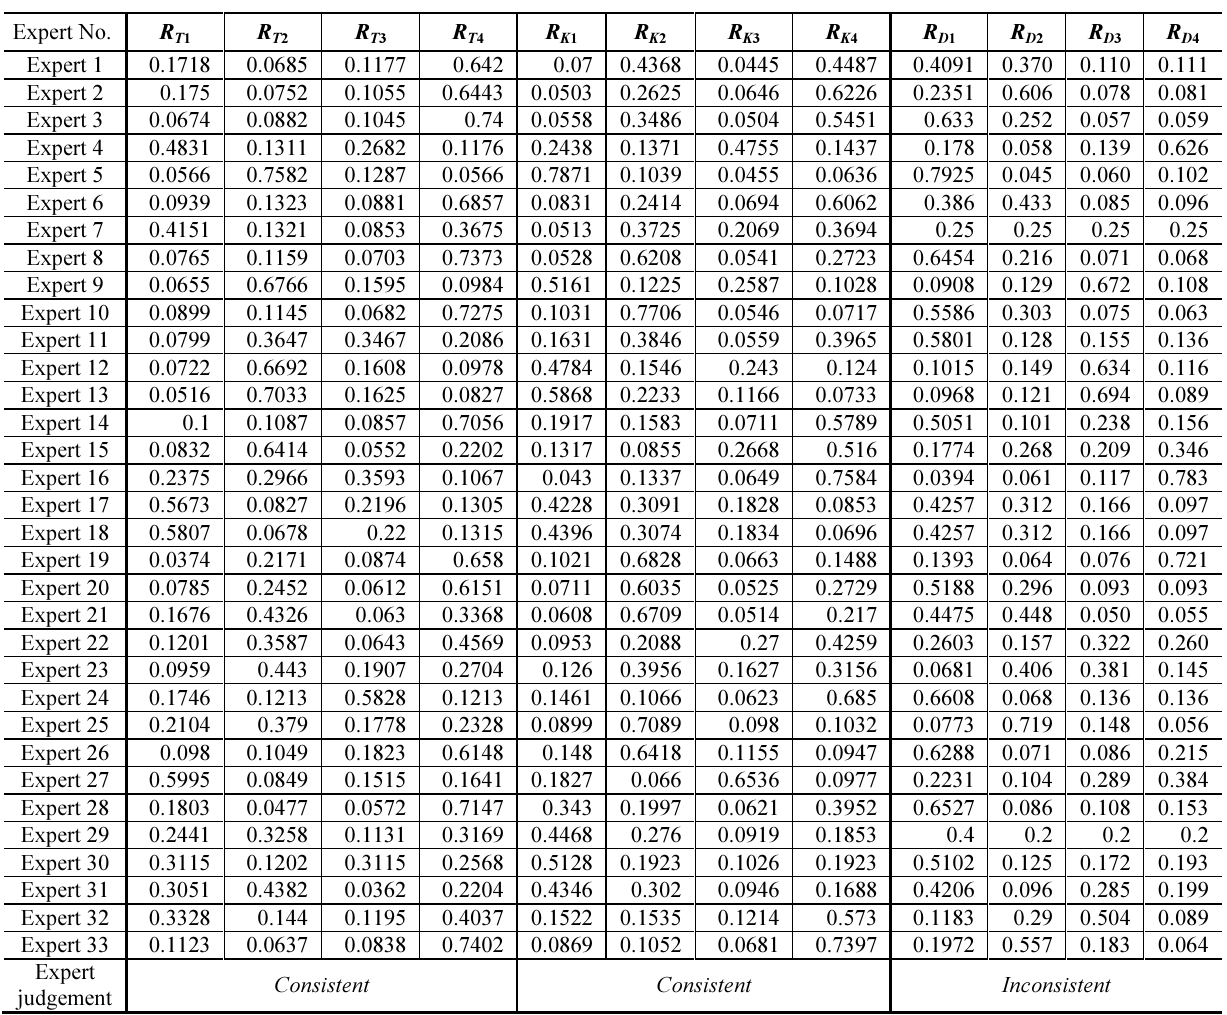
Table 3. The subjective values of attribute significance using data obtained by 33 experts Expert